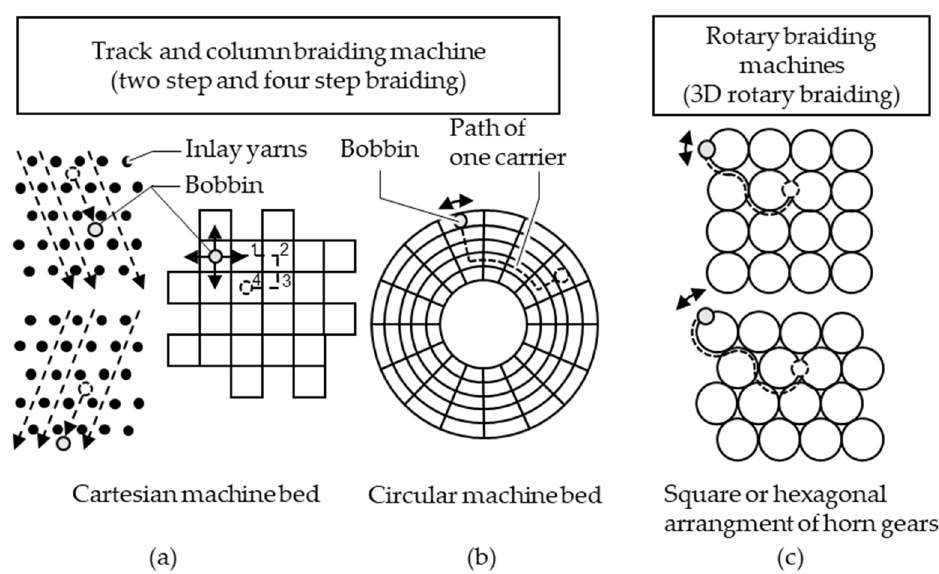
Figure 1. Comparison of track and column braiding machines with Cartesian ( a ) and circular ( b ) machine beds, as well as rotary braiding machines ( c ). Adapted from ref. [12].